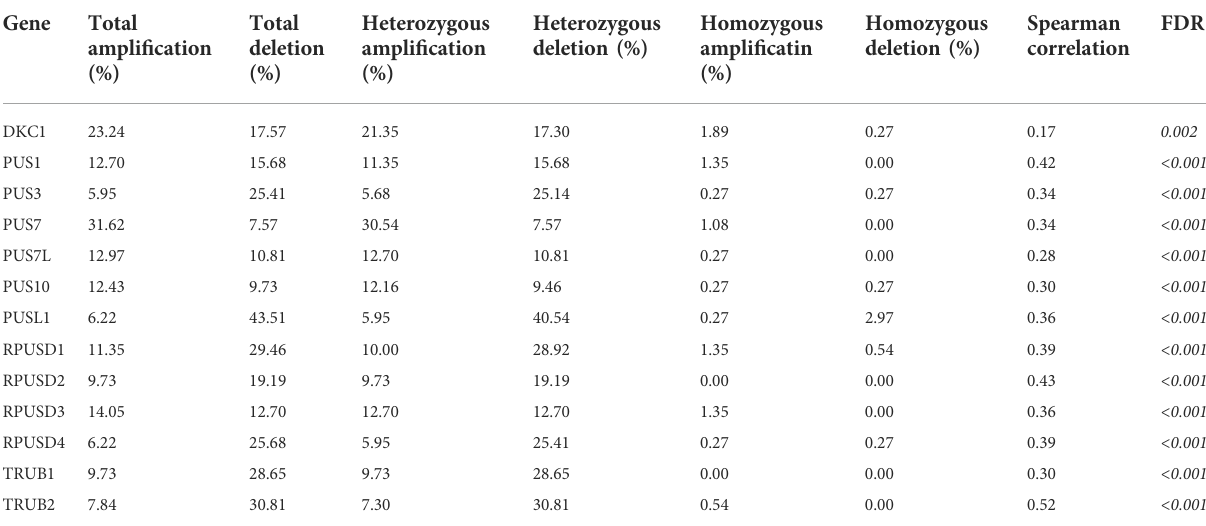
TABLE 3 Distribution of CNVs of PUSs and correlation of CNVs with PUSs expression in TCGA-LIHC. Copy Number Variation of PUSs in